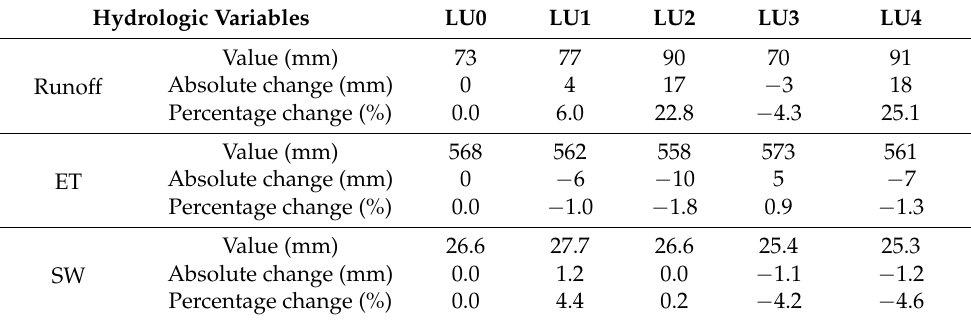
Figure 5. Seasonal runoff, ET, and SW in 1977–2016 under land use 0–4 in the Wooroloo Brook catchment, SWA. Table 3. Changes in mean annual runoff, actual evapotranspiration, and soil water using the SWAT model under LU0–4 in the Wooroloo Brook catchment, southwestern Australia in